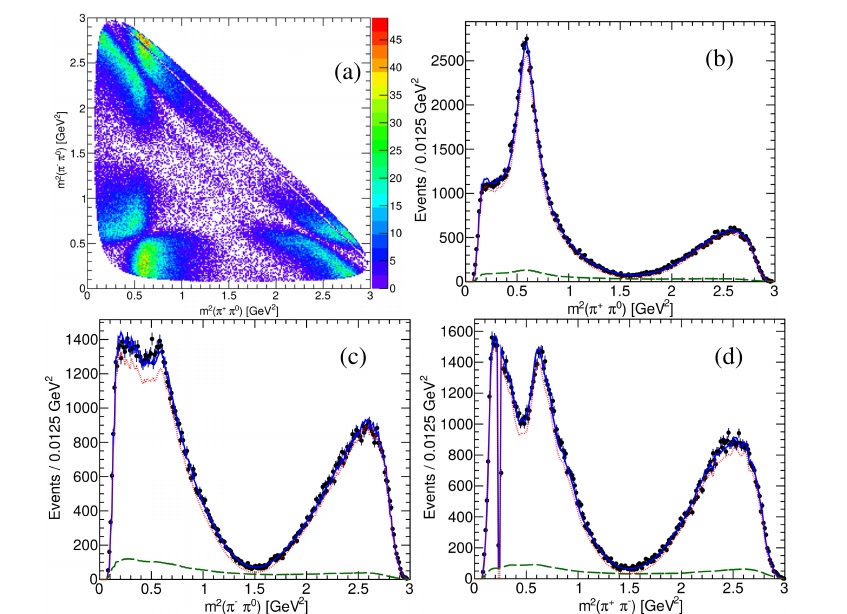
Figure 1. The Dalitz plot (a) of D 0 ! (cid:25) + (cid:25) (cid:0) (cid:25) 0 decay and the time-dependent Dalitz fit result of the Dalitz variables projections for m 2